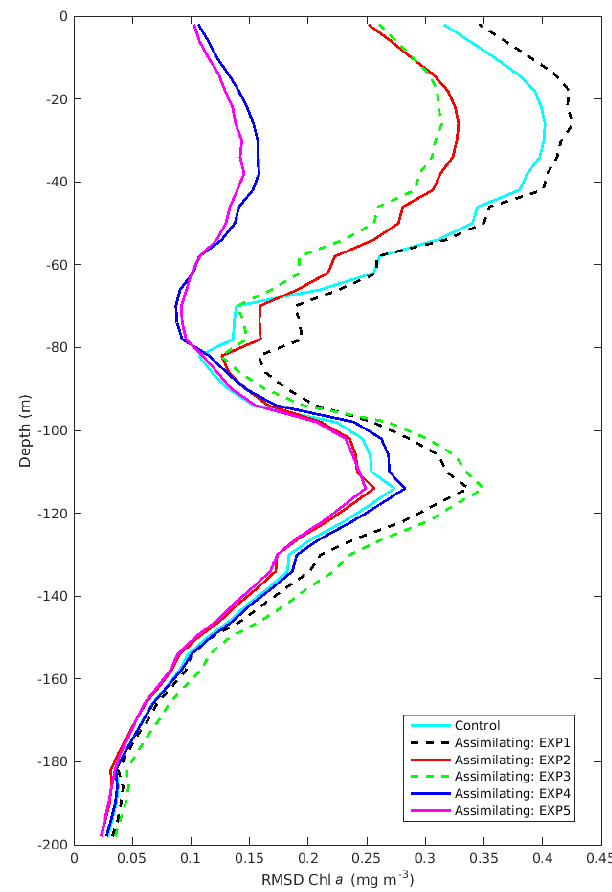
Figure 9. A profile of the temporal mean Chl a RMSD between the glider observations presented in Fig. 7 and the non-assimilating control (cyan), EXP1 (black dashed; note that the mean RMSD is calculated using a short time period), EXP2 (red), EXP3 (green dashed; note that the mean RMSD is calculated using a shorter time period), EXP4 (blue) and EXP5